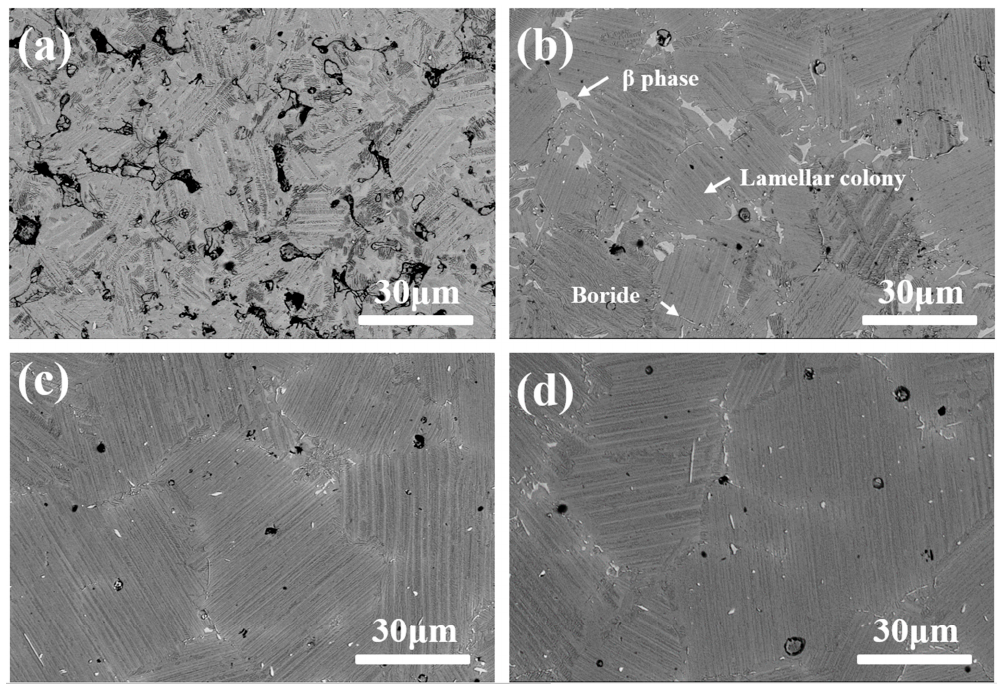
Figure 6. The microstructures of the specimens made from Feedstock F1 sintered at different temperatures: ( a ) 1440 °C; ( b ) 1460 °C; ( c ) 1480 °C; ( d ) 1500 °C.